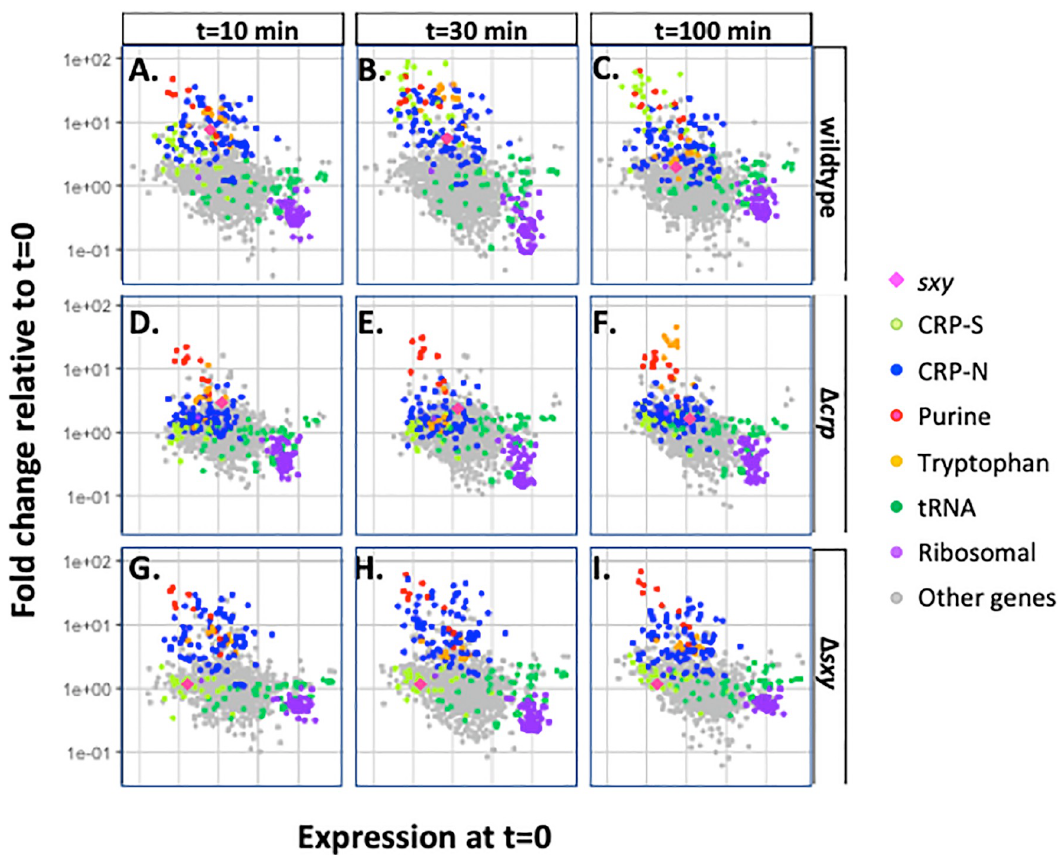
Fig 6. Competence-induced changes in transcript levels of H . influenzae genes regulated by CRP and Sxy. Each dot represents a gene, colour-coded by function: pink diamond: sxy ; light green dot: CRP-S-regulated; blue dot: CRP-N-regulated; red dot: purR regulon; yellow dot: tryptophan regulon; dark green dot: tRNA; purple dot: ribosomal proteins; grey dot: other or unknown functions. Each dot’s horizontal position indicates the gene’s relative transcript level (as FPKM) in rich medium (t = 0) and its vertical position indicates how this level changed at later time points ( A : t = 10; B : t = 30; C : t = 100) or in a mutant background at T = 30 ( D-F ; Δ crp ; G-I : Δ sxy